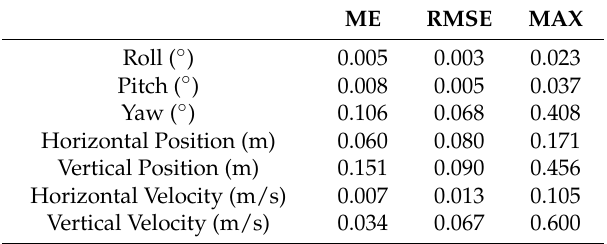
Table 3. Statistical analysis of position and attitude estimation error in Scheme